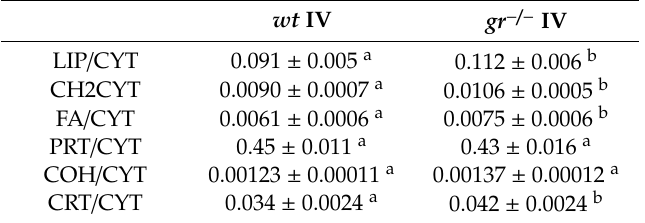
Table 3. Biochemical composition of the cytoplasm of class IV wt and gr − / − oocytes. wt IV